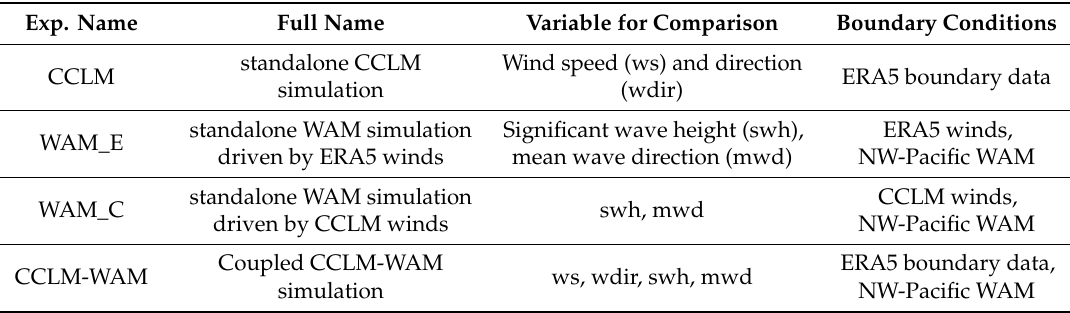
Table 1. Experiment